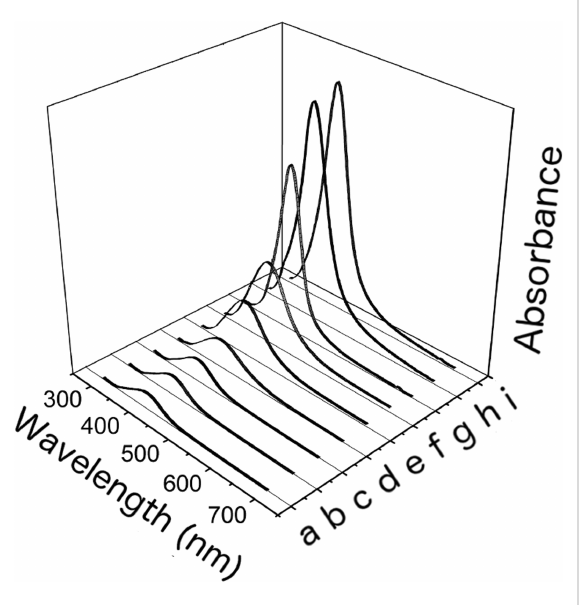
Figure 1: UV–vis absorption spectra obtained from (a) the colloidal solution without ammonia and (b–i) from solutions containing 0.01, 0.1, 1, 5, 10, 100, 1000 and 2000 ppm ammonia.